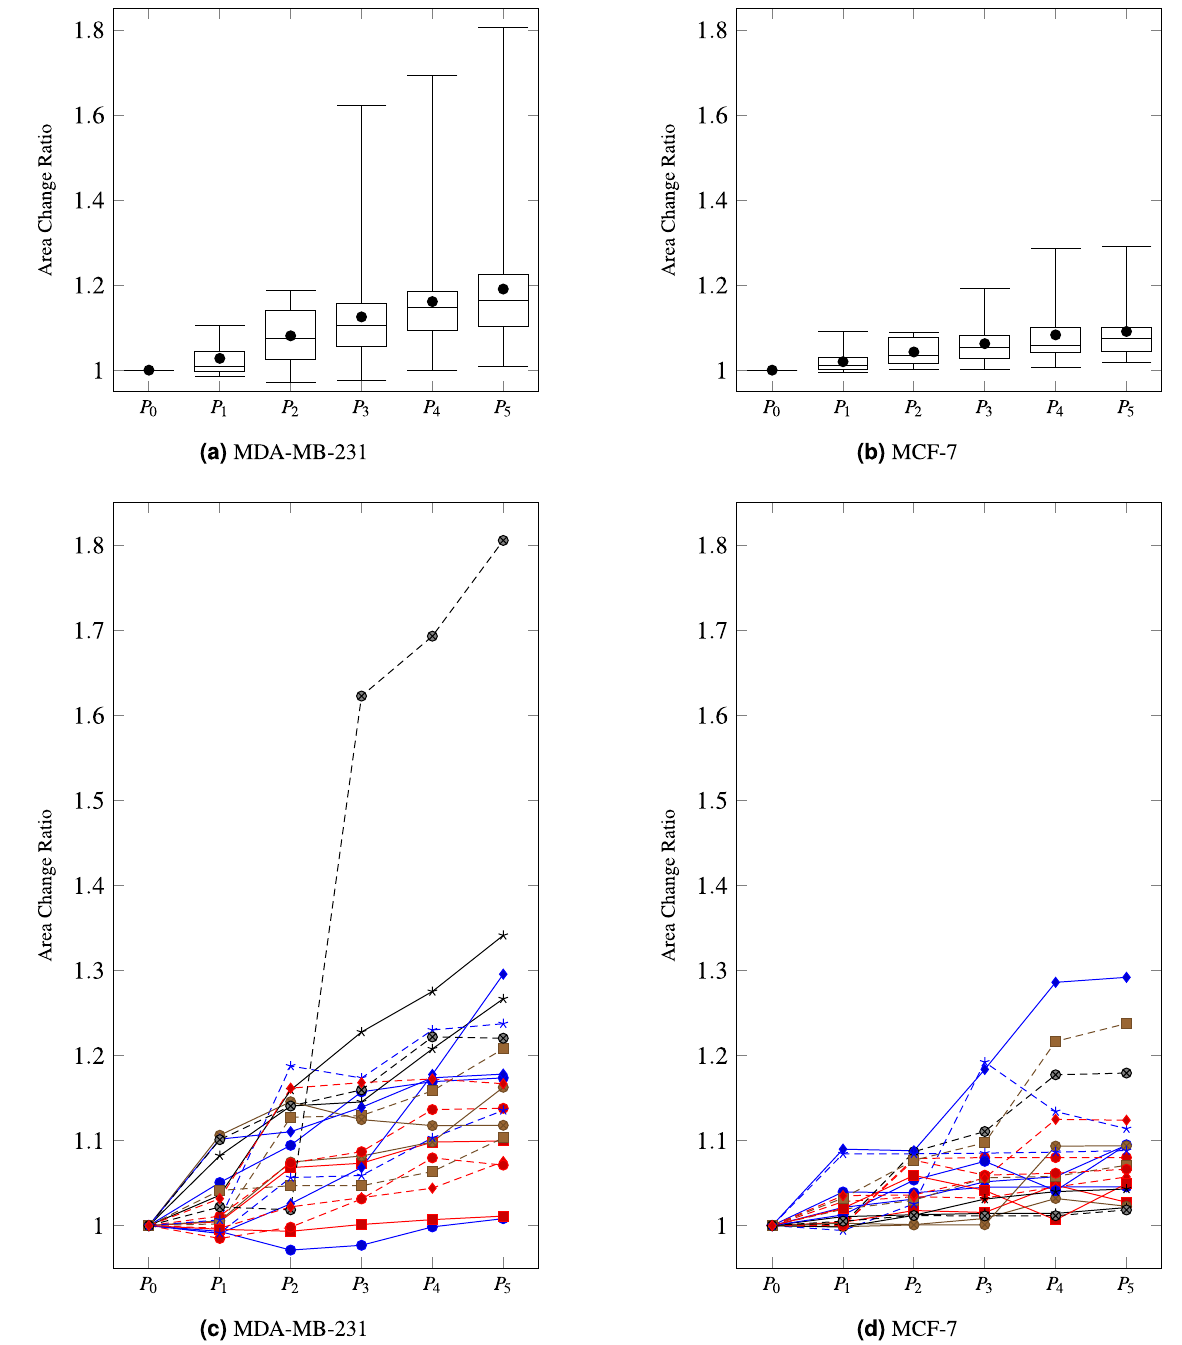
Figure 2. Distributions of area change ratios of cancer cells. ( a , b ) present distributions of manually measured area change ratios of the two types of cancer cells (20 cells for each type), MDA-MB-231 and MCF-7, respectively. The three horizontal lines indicate the first, second, and third quartiles of the area change ratios. The tops and bottoms of the whiskers refer to the maxima and minima of area change ratios, respectively. Circular dots denote average area change ratios. ( c , d ) show the manually measured area change ratios of each cell, individually. These figures exhibit that cell area changes are not proportional to pressure levels and have diverse tendencies even in a cell-type. In addition, these figures reveal that differences in the area change ratios between the two types are as distinct as we can distinguish types of cancer cells according to the